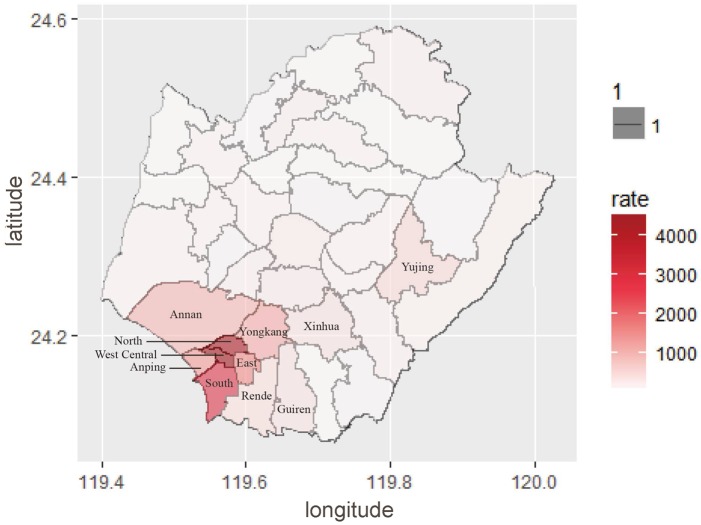
District-specific dengue incidence intensity map in 2015 Tainan.